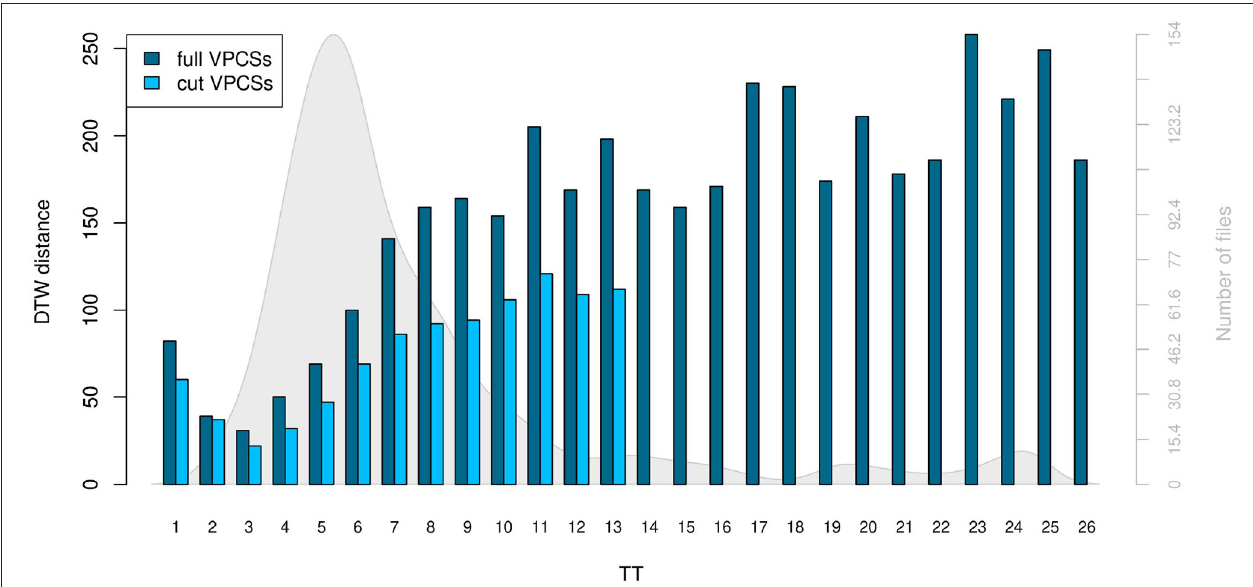
FIGURE 7 | Distances calculated by DTW. The differences between stVPCS and the averaged VPCSs of all files grouped by their respective TT are shown in dark blue (full sequences) and light blue (cut sequences). The distances of the cut sequences are lower than the distances of the full sequences. In both TT 3 has the lowest distance to the stVPCS. The gray background graph and the corresponding axis on the right illustrate the number of files in the different groups.